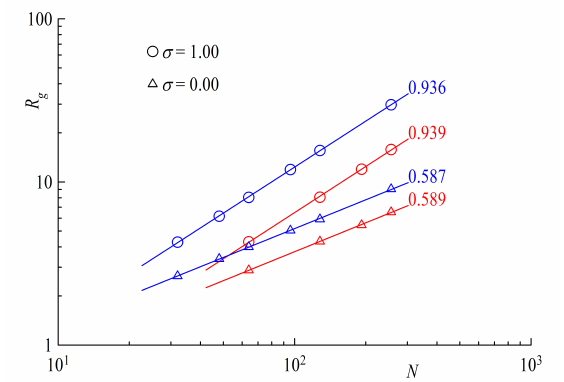
Figure 5. Radius of Gyration R g as a function of chain length N . Straight lines indicate power law fits with scaling exponents shown next to the line. Red symbols are rings and blue for tails.